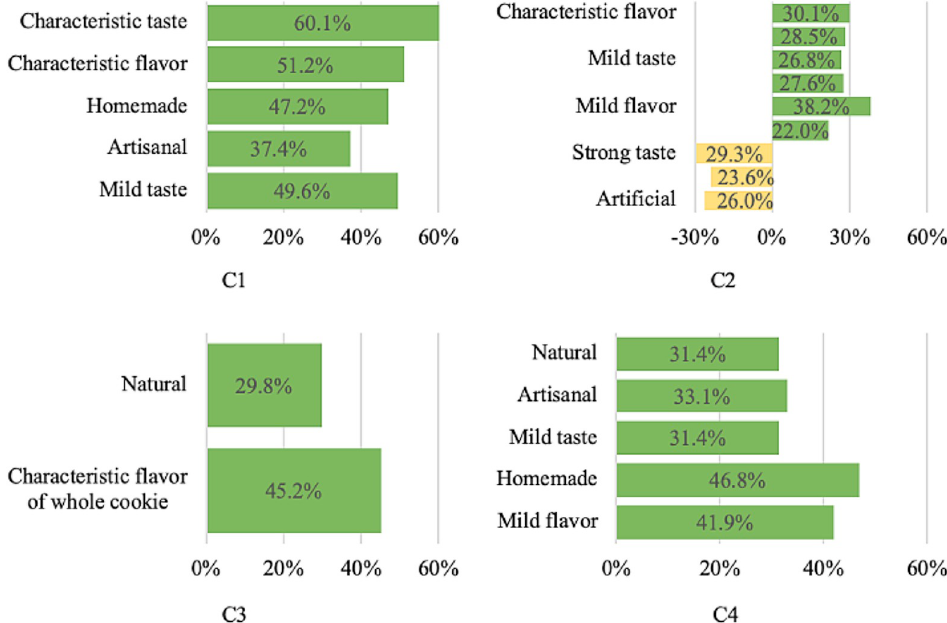
Fig 5. Attributes with a significant effect on the overall acceptability of the cookies. C1—wheat flour cookies (control1), C2–50% xiquexique flour (100 mesh) cookies, C3—whole wheat flour cookies (control2) and C4–50% whole xiquexique flour (28 mesh)